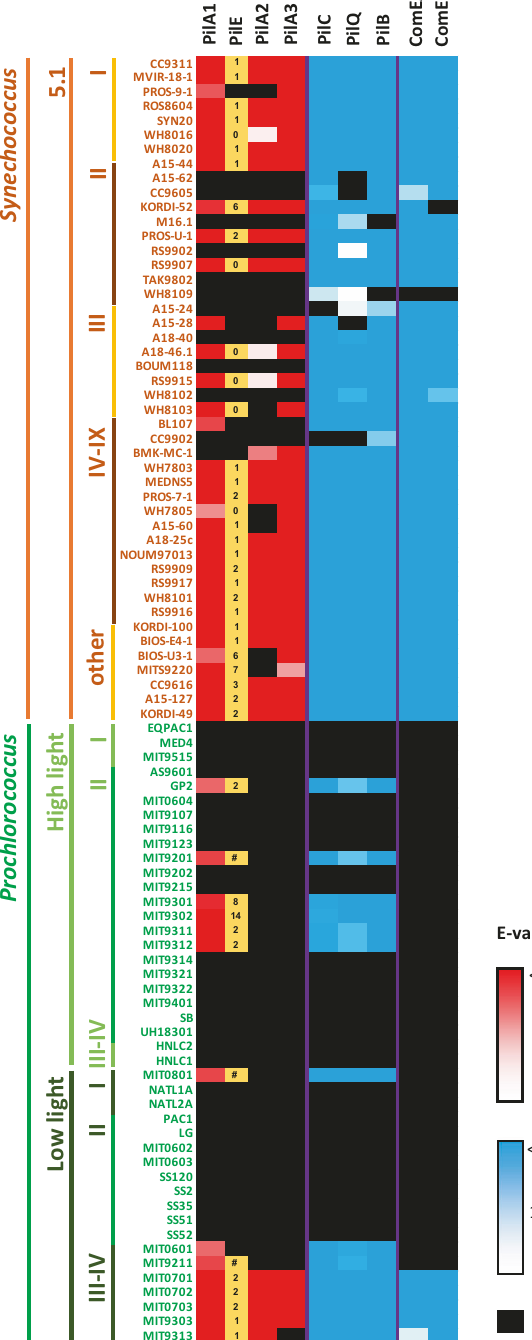
Fig. 2 The presence of pilus-related proteins in cultured marine picocyanobacteria strains. Pilus proteins from Synechococcus sp. WH7803 were used for the BLASTp search. Log10 E-value scales are shown (1 to <10 − 10 , white to red; and 1 to <10 − 70 , white to blue). Black cells represent proteins that were not detected (ND). Numbers in the ‘ PilE ’ column indicate the genomic distance between pilE and pilA1 homologues (e.g. 1 denotes pilE and pilA1 are contiguous in the genome; 0 denotes the same gene gave homology to both pilE and pilA1 due to the conserved N-terminal of the protein; # denotes both genes are separated by >20 genes). PilC, PilQ and PilB were used to determine the presence of the pilus transmembrane apparatus. ComEA and ComEC were selected to determine the presence of the additional machinery required for